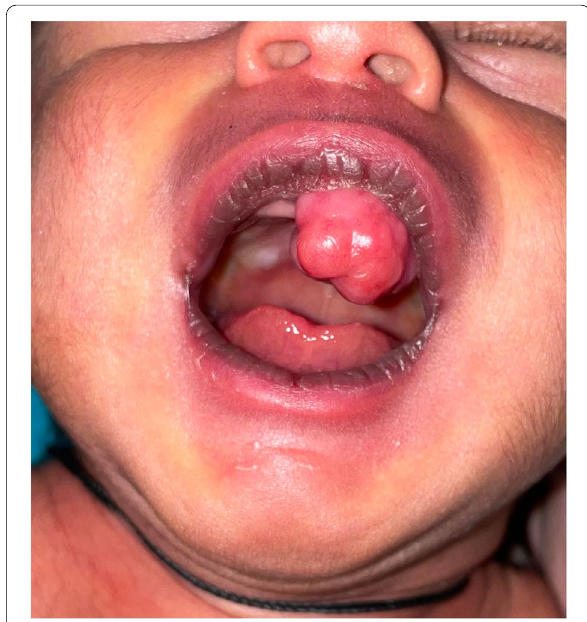
Fig. 1 Clinical picture of the child at presentation